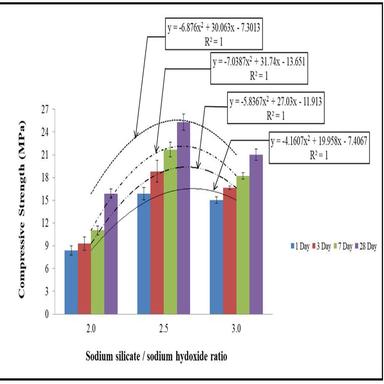
Coefficient of determination (R2 ) for effect of sodium silicate/sodium hydroxide solution ratio on 1, 3, 7 and 28 day compressive strength.